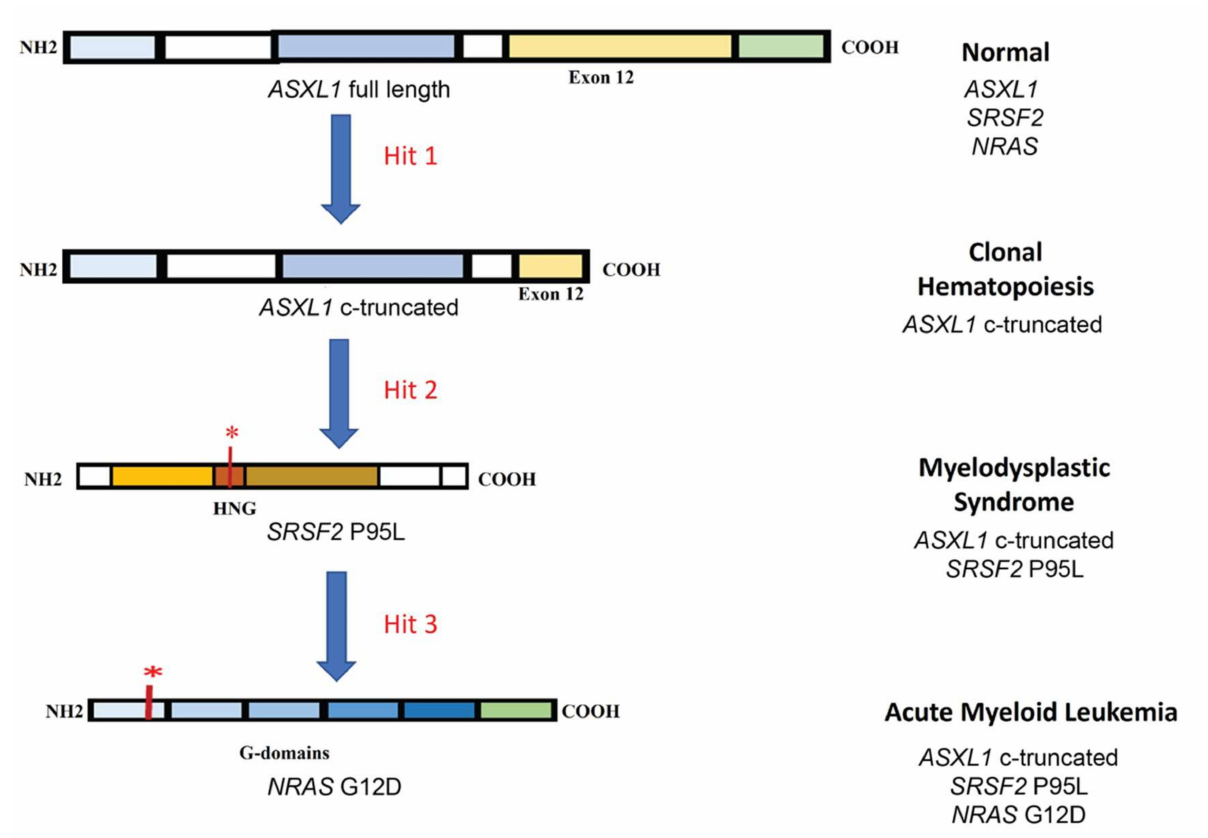
Figure 1. Schematic of clonal evolution of AML. The first step in the process is mutation in transcriptional regulator ( ASXL1 ) resulting in a c-terminal truncated protein. The next step is a point mutation in hinge region (HGN) of the RNA splicing regulator ( SRSF2 ) affecting the protein binding to canonical splicing enhancer sequences in RNA. The third hit is mutation in signaling molecule ( NRAS ) resulting in differentiation block and hyperproliferation. * indicates